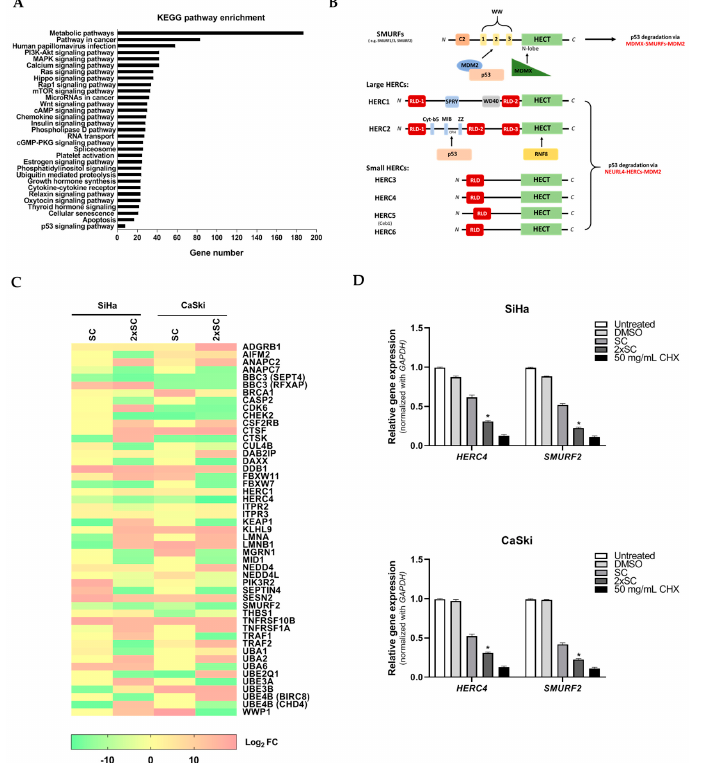
Figure 4. Analysis of the functional pathways of the differentially expressed proteins in Androg-treated HPV16-positive cervical cancer cell lines. ( A ) The functional pathway classifications of the differentially expressed proteins by KEGG platform. ( B ) Identification of p53 protein–protein interaction sites of certain HERC subfamily HECT E3 ligases linked to oncogenesis. ( C ) Overall view of the differential expression of proteins in Androg-treated cells. ( D ) Verification of HERC4 and SMURF2 that were differentially expressed among two paired untreated and Androg-treated sublines by qRT-PCR. * p < 0.05.